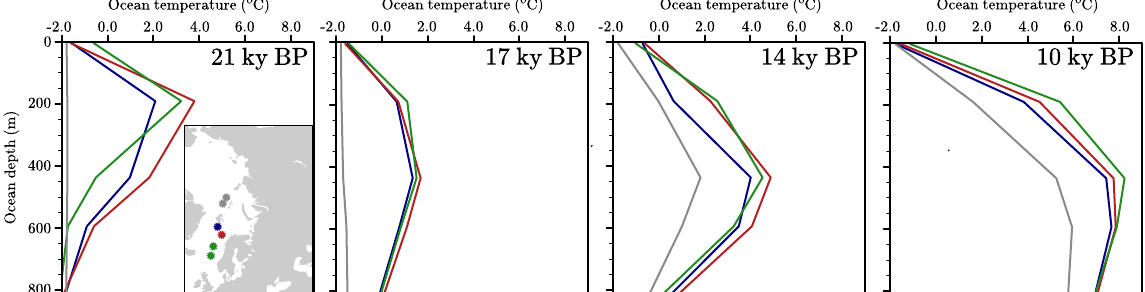
Figure 3. Ocean temperature vertical profiles derived from TraCE-21ka climate simulation 22 at four different time slices (21, 17, 14, 10 ka). The vertical profiles are representative of the Norwegian Sea (green), South- Western Barents Sea (red), North-Western Barents Sea (blue) and Arctic Ocean (grey). In the inlay map, the points selected in the TraCE-21ka grid to derive the vertical profiles are